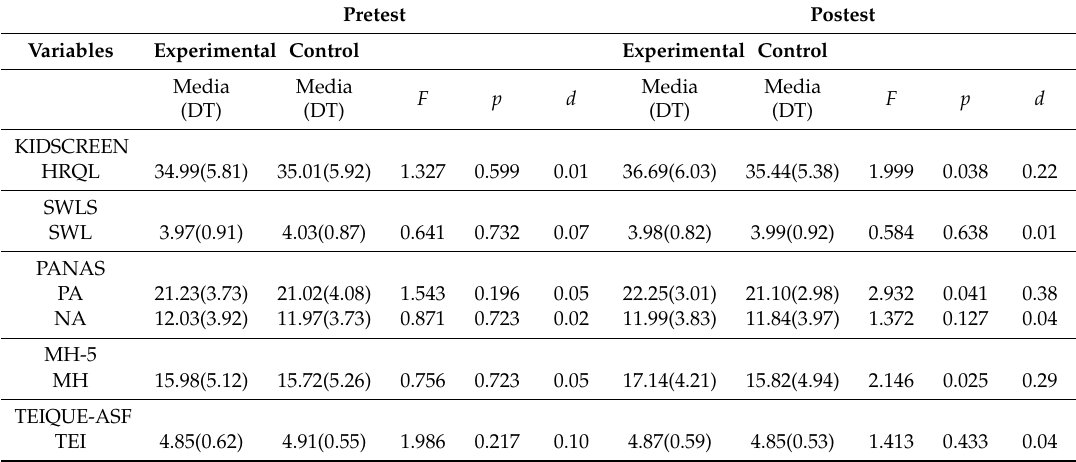
Table 3. Pretest and posttest measures for experimental and control